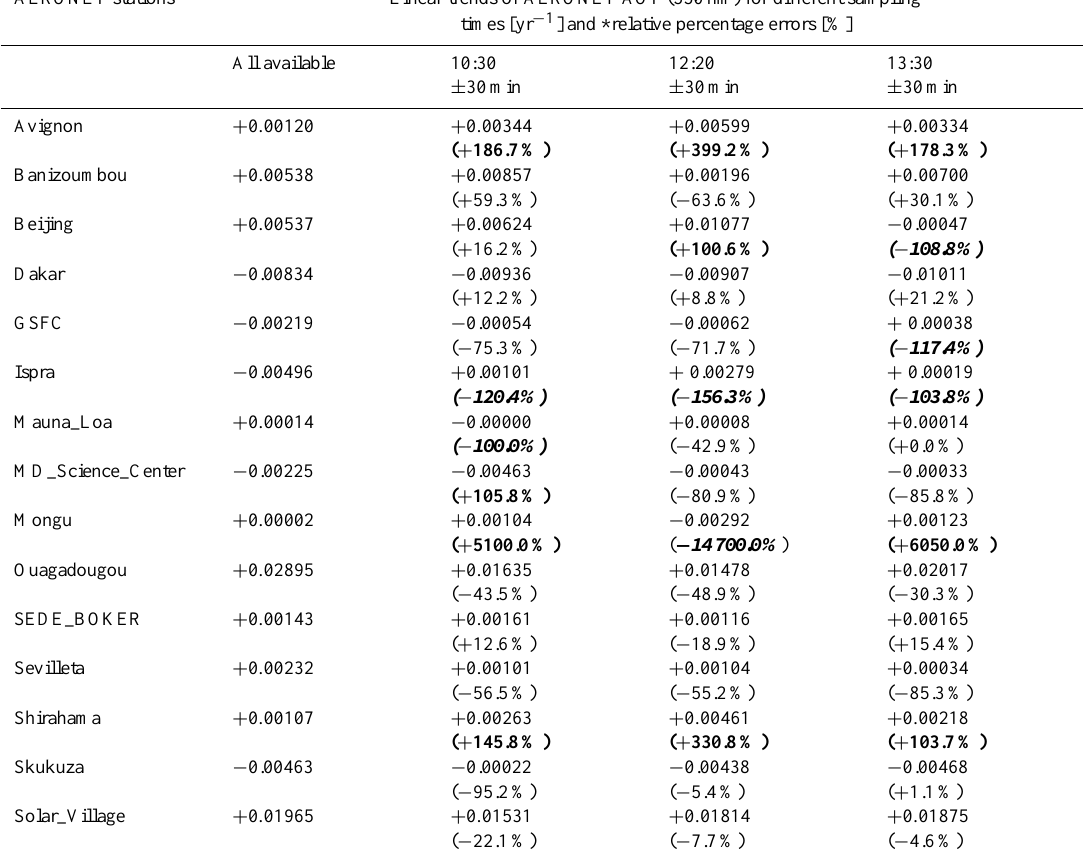
* The trend estimates from all available and limited/different temporal samplings at the selected AERONET stations are denoted by T Actual and T Reampling , respectively, and the relative percentage errors (RPE) between them are defined as